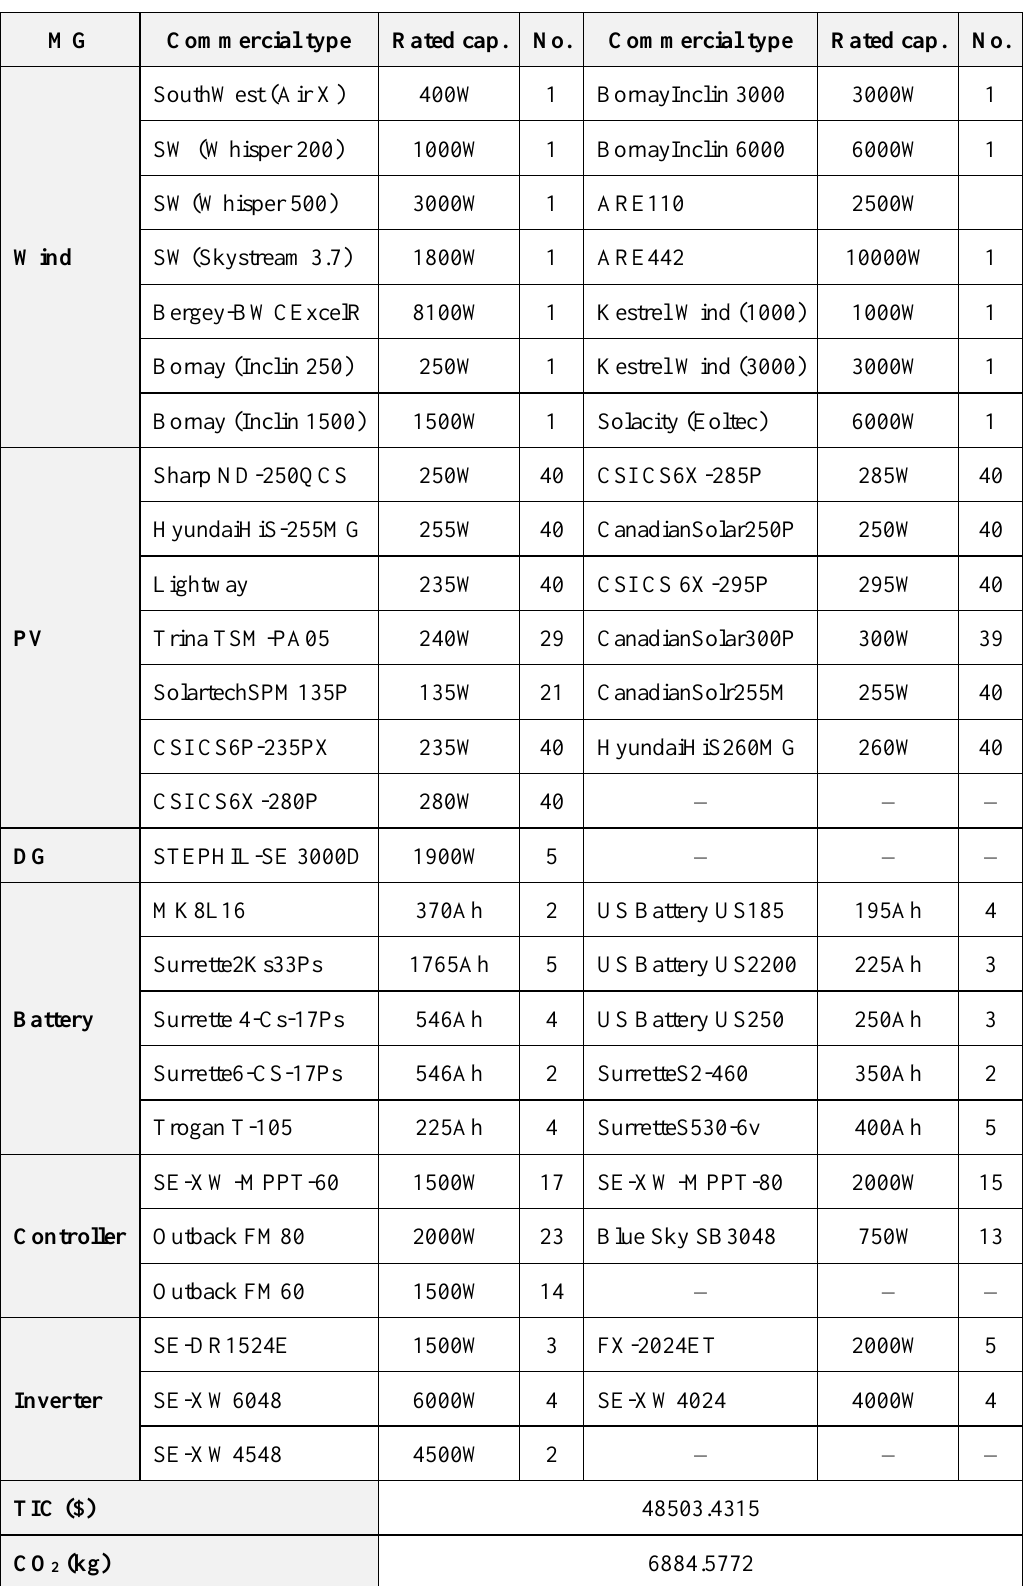
Table 9. MG sizing optimization results with emission